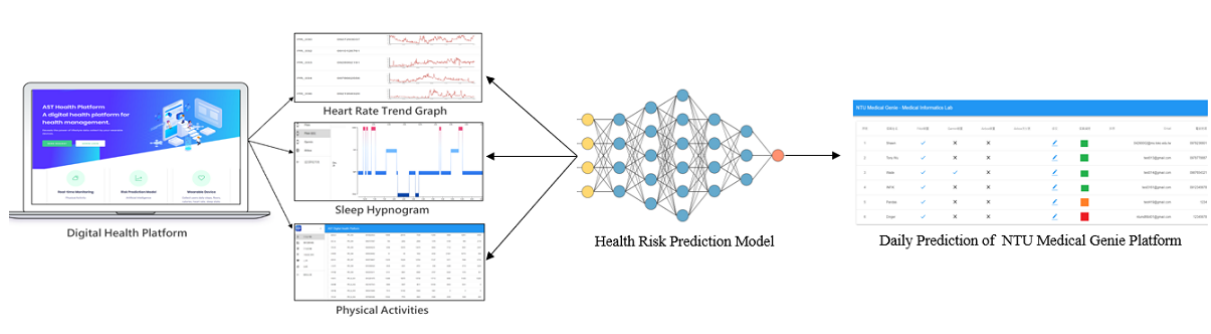
Figure 13. Acute exacerbation of chronic obstructive pulmonary disease prediction